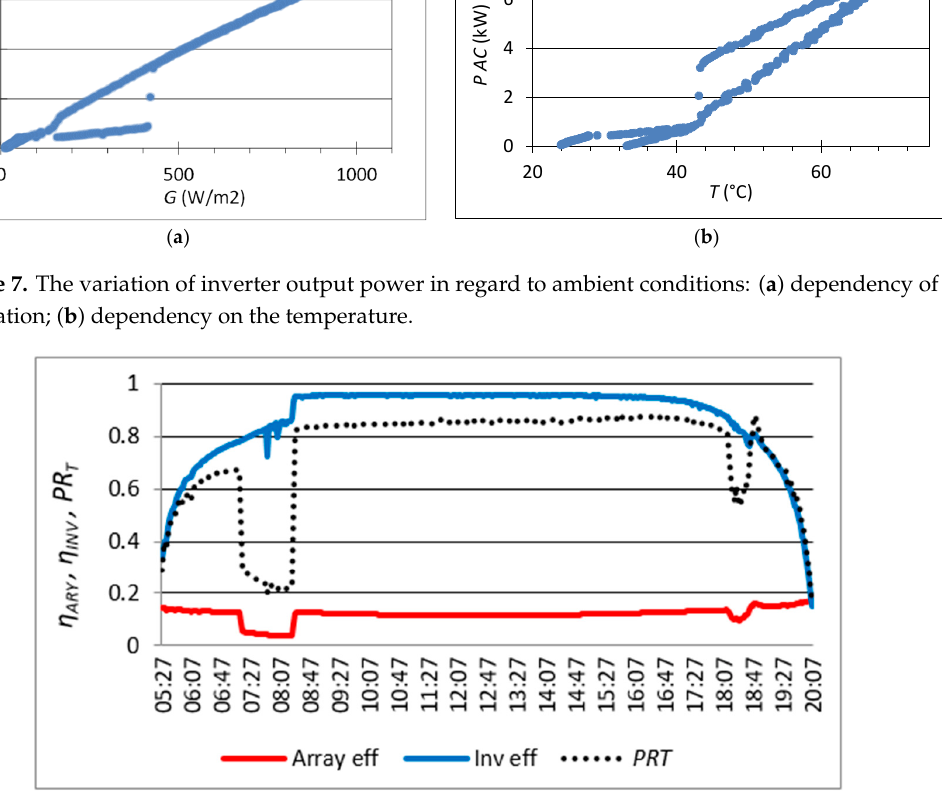
Figure 8. Performance ratio, array and inverter efficiency changes during one day measurement.